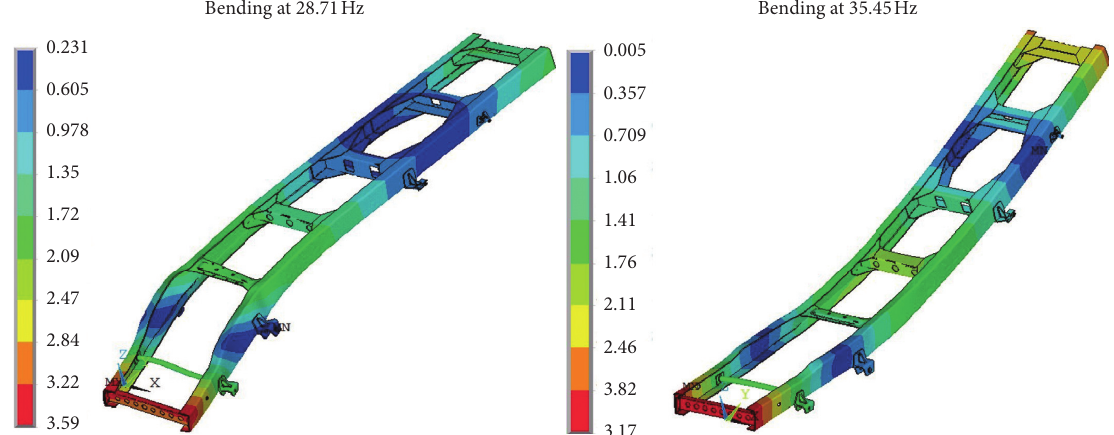
Figure 3: Mode shapes of the constrained chassis at 28.71Hz and 35.45Hz.